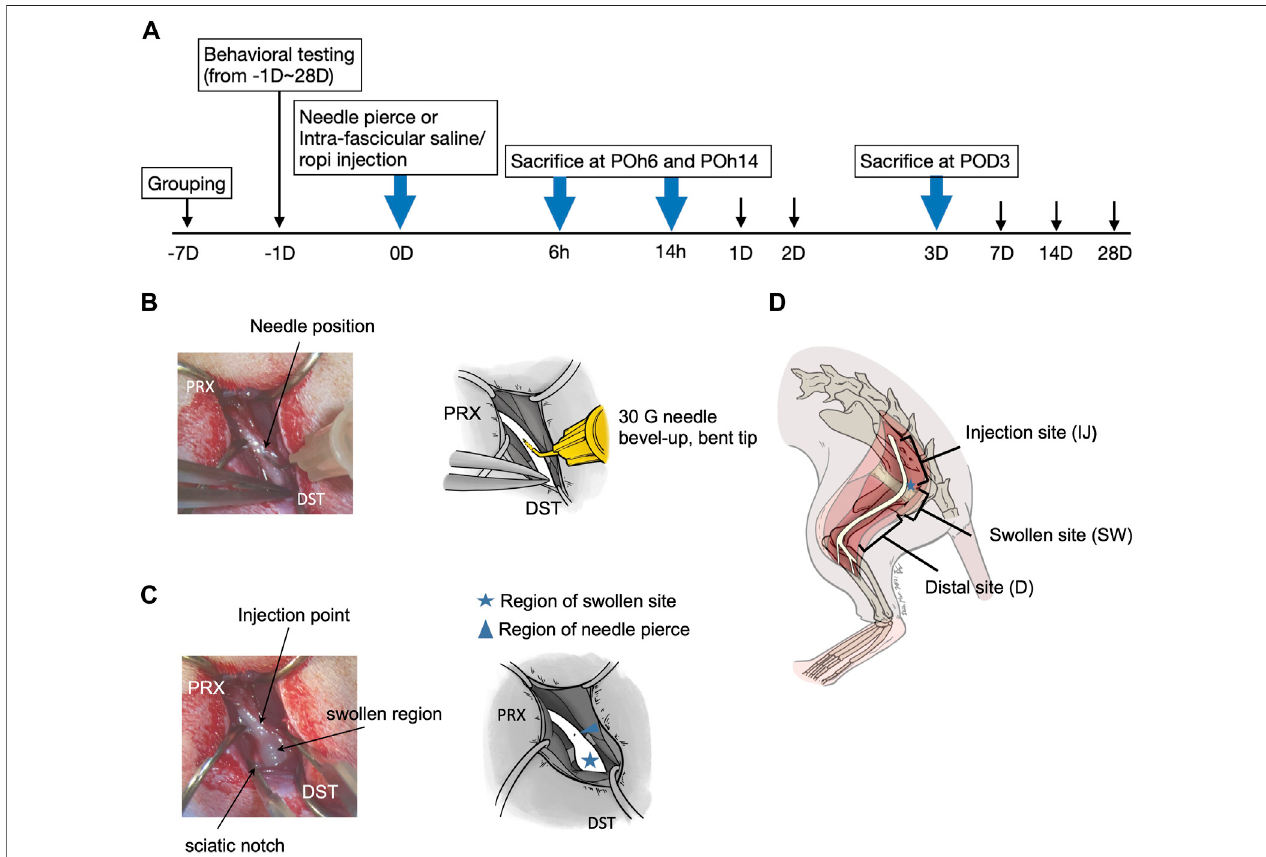
FIGURE 1 | (A) Flow chart of the study (B) Left sciatic nerve exposed and site with 30 G needle nerve piercing (C) Left sciatic nerve exposed with injectates intrafascicularinjection(30 µl) (D) Sciaticnervesweredividedintothreesections,injectionsite(IJ);thelengthbetweentheproximalcut-offpointtoaboutuppermarginof theobturatorandgemellimuscles,swollensite(SW);thelengthapproximately10 mmencompassingthenotchregion,distalsite(D);lengthbetweenthelowermarginof the sciatic notch to the cut-off point (distal end before it divided to branches). POh, post-operation-hour; POD, post-operation-day.